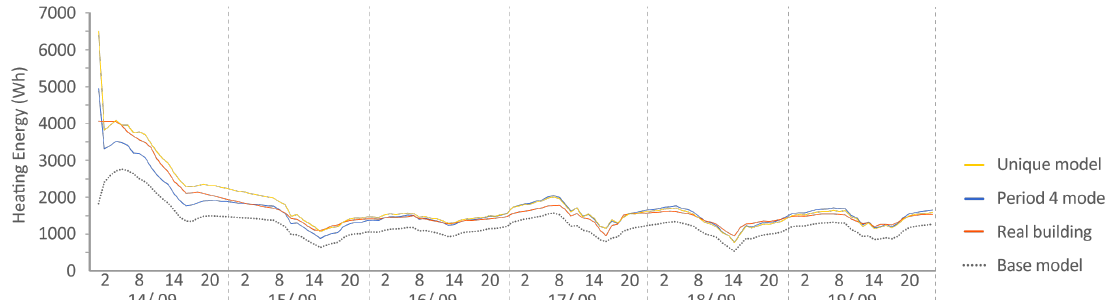
Figure 19. Energy consumed by house N2, Period 4 (set point at 25 ◦ C). Period 4 model: CV(RMSE): 11.76%, NMBE: − 0.05%, and R 2 : 91.70%. Base model: CV(RMSE): 30.98%, NMBE: 0.11%, and R 2 :